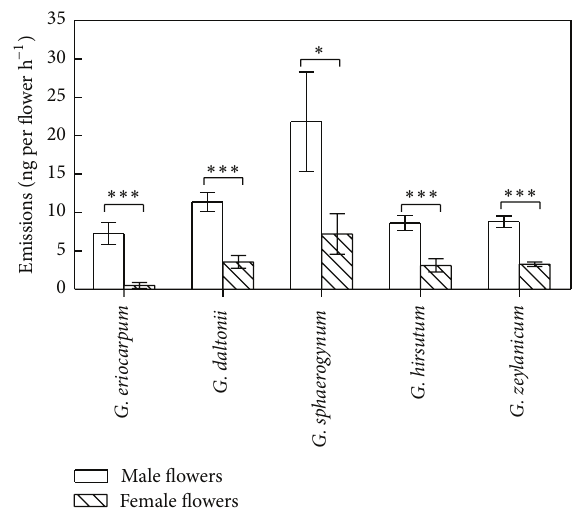
Figure 5: Total emission (Mean ± SD) of scent compounds from male and female flowers of five Glochidion species (unpaired 𝑡 -test: “ ∗ ” and “ ∗∗∗ ” on the bars indicate significant difference at 𝑃 = 0.05 and 0.001